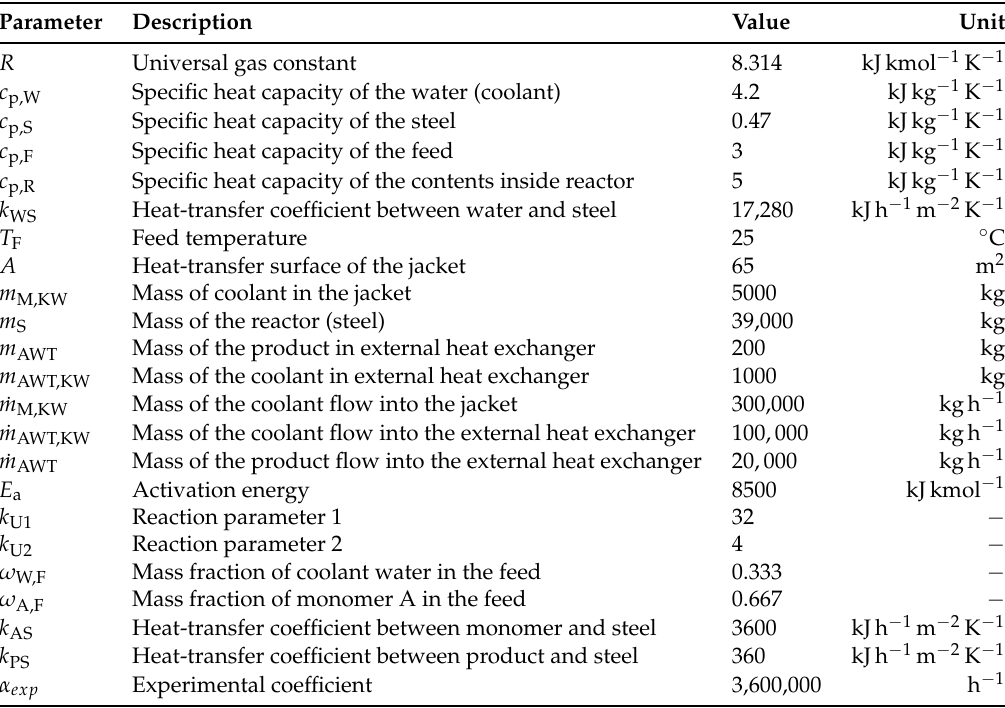
Table 7. Case study 2: Model